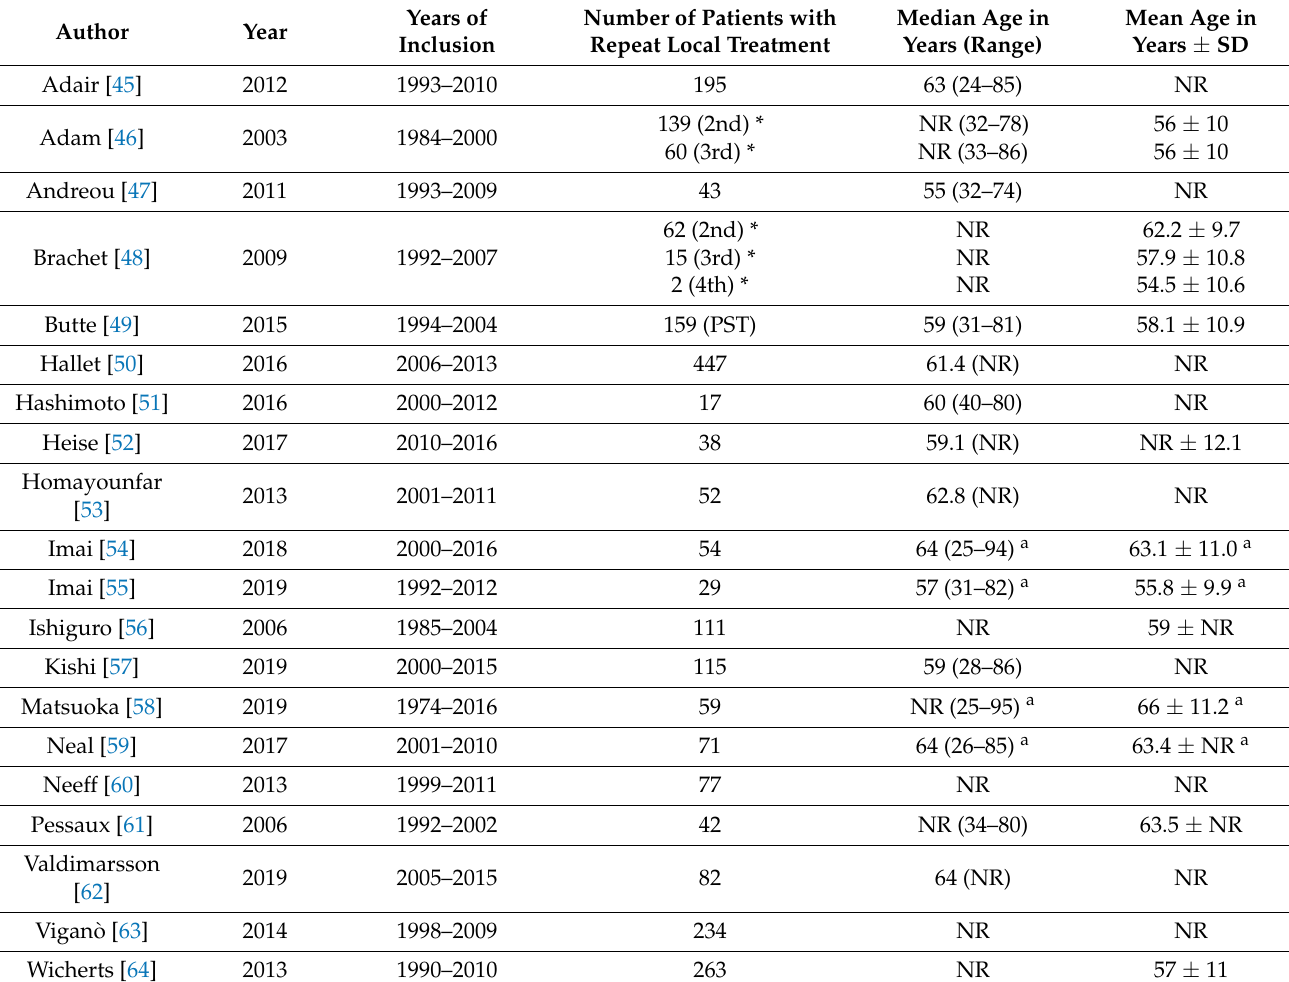
Table 1. Characteristics of studies reporting on patients with repeat local treatment for recurrent colorectal liver metastases including years of inclusion, study design, number of patients, and